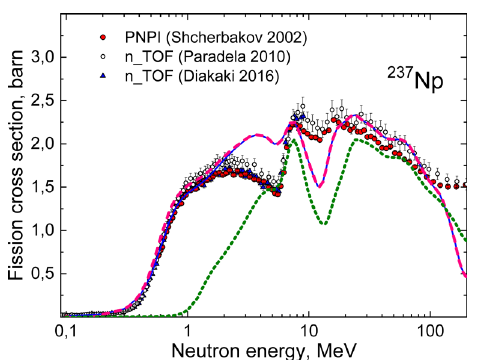
Figure 5. Fission cross section of 237 Np: experimental data [27– 29], the dotted line is the calculation with default set of TALYS parameters, the solid and dashed lines are the variants 1 and 2 of calculations with adapted parameters, respectively (see